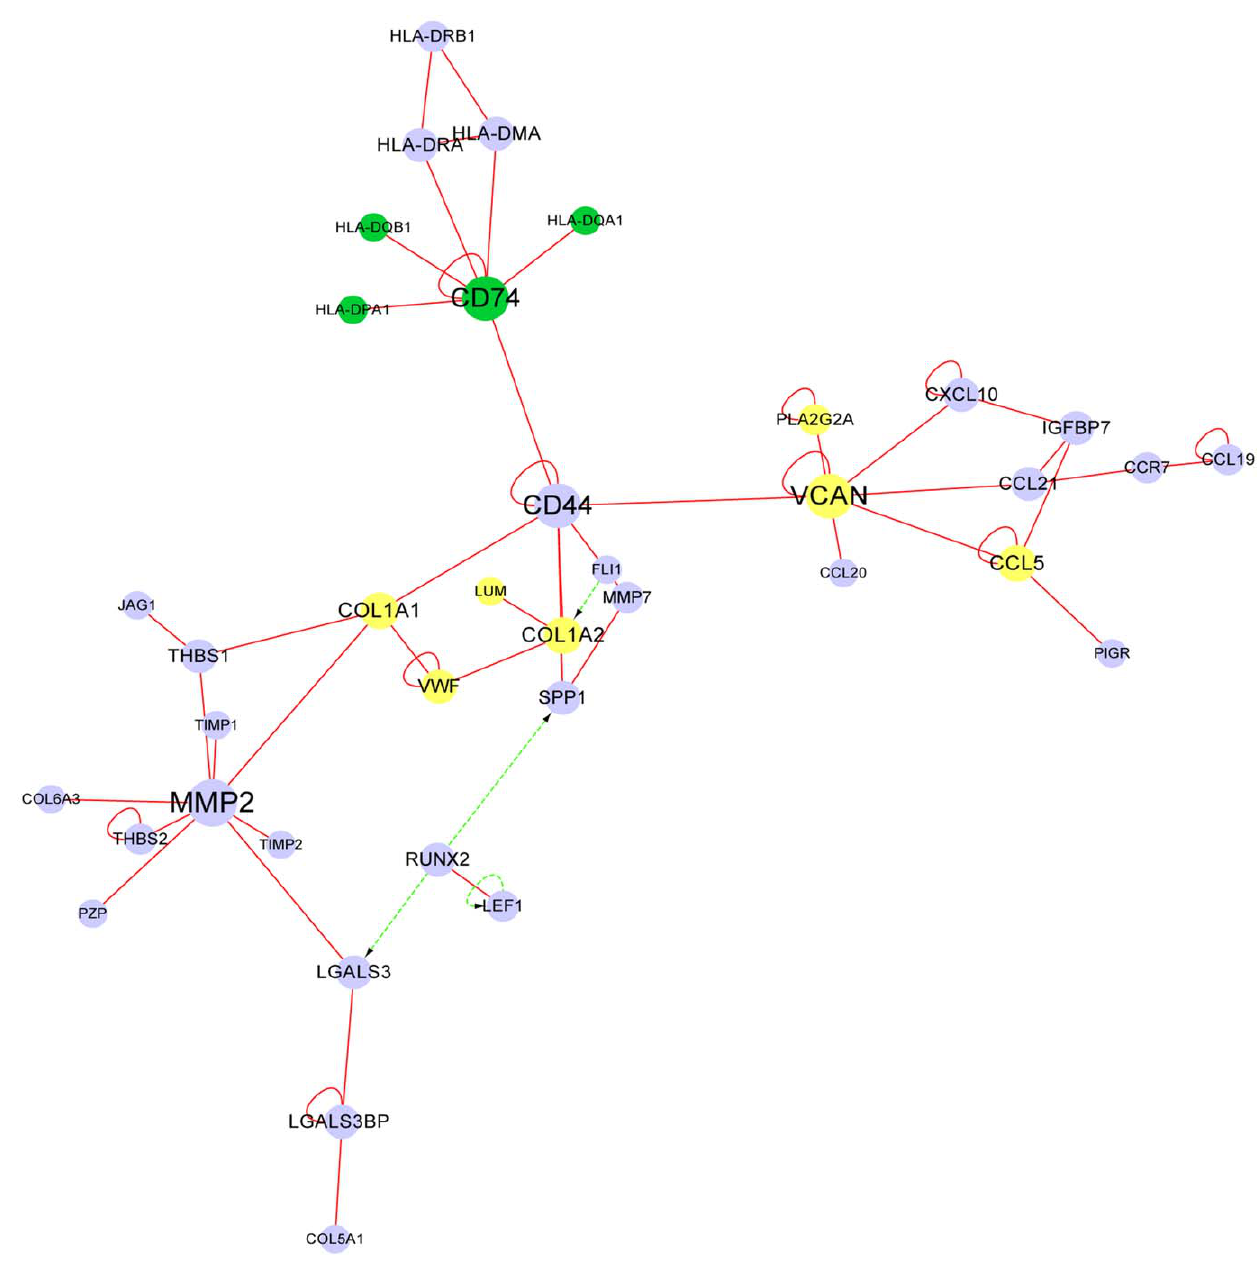
Figure 4. Cirrhosis-related network mentioned in discussion. Node color: green, nodes used to be in cirrhosis-HCC-risky sub-network; yellow, nodes in HCC-risky sub-network; purple, other nodes in cirrhosis-related network. Edge color: red, PPI; green, TRI. Edge direction: undirected, PPI; directed, TRI, from transcriptional factor to target gene.